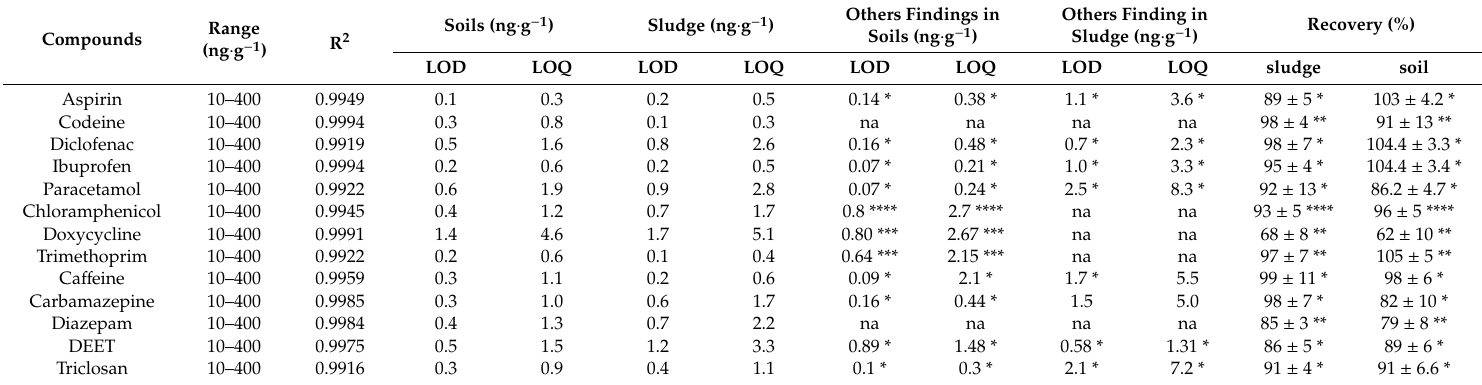
Table 1. Compounds, range of concentration, regression coe ffi cients, limit of detection, and limit of determination of this finding and others the two substrates with their %